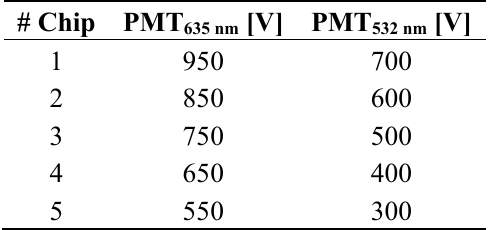
Table 1. PMT settings of different DNA